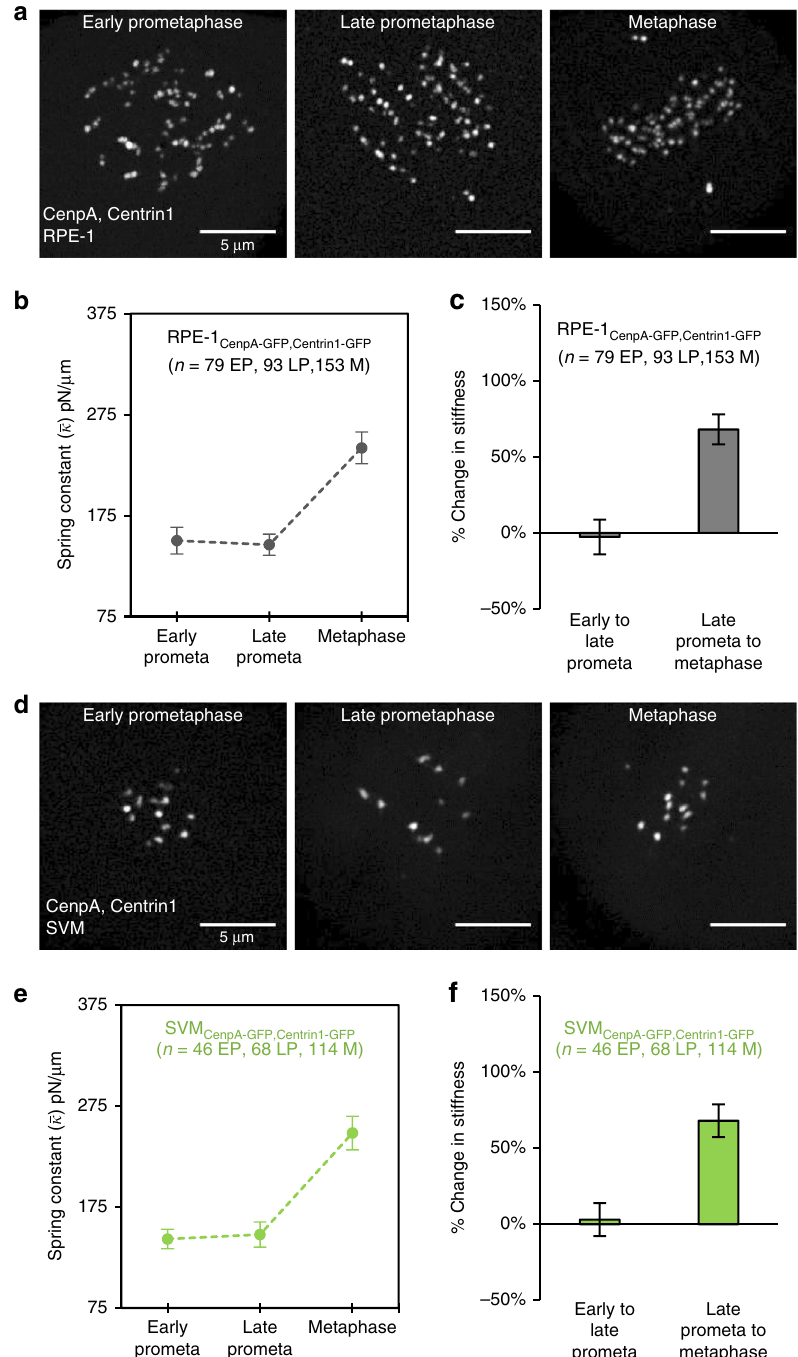
Fig. 2 Stiffness of the centromere-spring matures during mitotic progression. a Live cell imaging of human RPE-1 cells expressing CenpA-GFP at the outer centromere and Centrin1-GFP at the spindle poles. Images are maximum intensity projections from full-cell-volume image series, and are representative of the described mitotic stages: early-prometaphase (left), late-prometaphase (center), and metaphase (right). b Mean spring constant by mitotic stage for RPE-1 cells (early-prometaphase = 79 chromosomes, 39 cells; late-prometaphase = 93 chromosomes, 26 cells; metaphase = 153 chromosomes, 49 cells). c Percent change in mean stiffness of the centromere-spring between early- and late-prometaphase (left) and late-prometaphase and metaphase (right) for RPE-1 cells. Percentages calculated using data shown in 2B. d Live cell imaging of Indian muntjac SVM cells expressing CenpA-GFP at the outer centromere and Centrin1-GFP at the spindle poles. Images as described in a . e Mean spring constant by mitotic stage for SVM cells. f Percent change in mean stiffness of the centromere-spring between early- and late-prometaphase (left) and late-prometaphase and metaphase (right) for SVM cells. Percentages calculated using data shown in e . The scale bar for all images is 5 μ m. All error bars represent standard error. All n -values listed are chromosome numbers. See also Supplementary Figs. 1 and